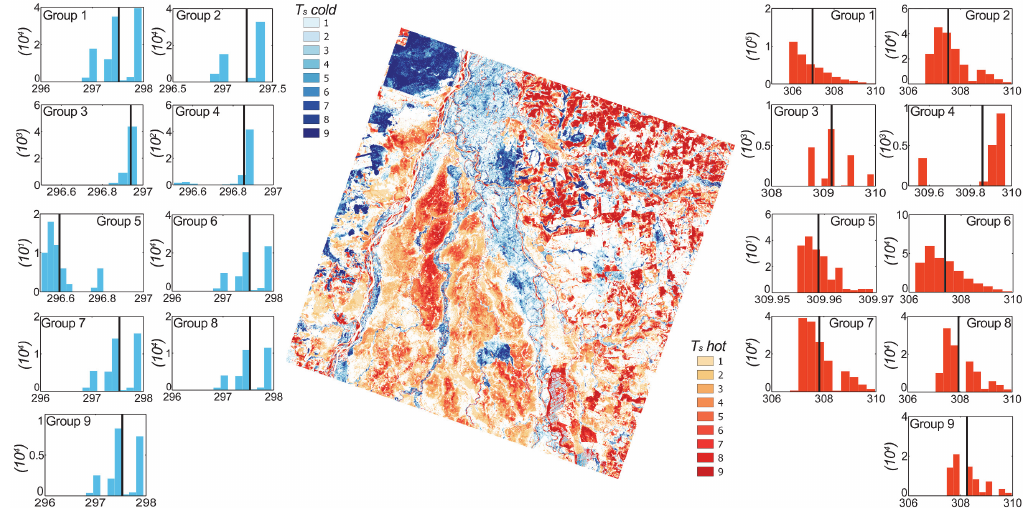
Figure 9. Example of endmember pixel selection for the year 2004 DOY 200 ( center ). T s cold ( left ) and T s hot ( right ) represent the hot and cold endmember candidates for each quantile group, respectively, while the black line indicates the selected endmember T s . For each column chart, the y -axis represents pixel frequency while the x -axis represents T s